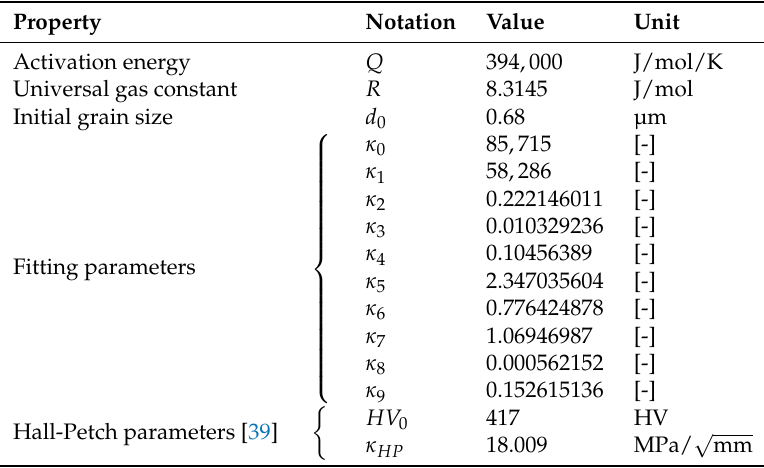
Table 5. Zener-Hollomon and Hall-Petch parameters of AISI